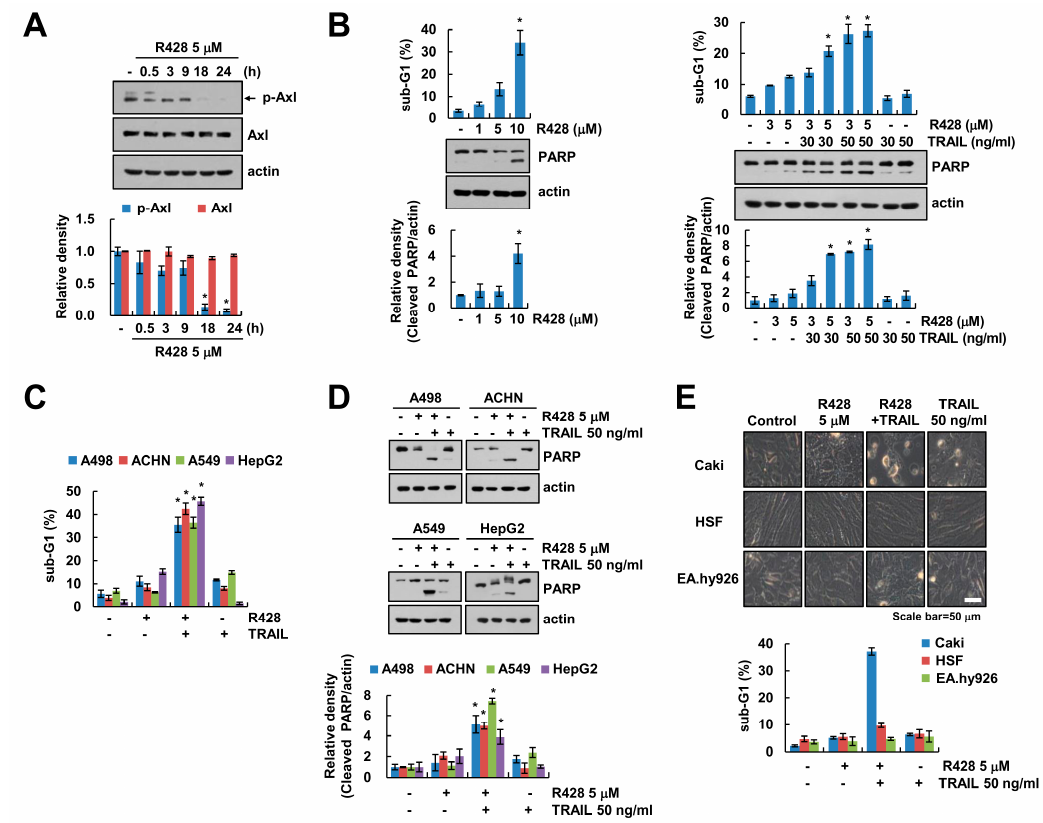
Figure 1. Inhibition of Axl increases TRAIL (tumor necrosis factor-related apoptosis-inducing ligand)-mediated apoptosis of cancer cells, but not normal cells. ( A ) Caki cells were treated with Axl inhibitor (R428) for the indicated time kinetics. ( B ) Caki cells were treated with 1–10 µM R428 for 24 h (left panel). Caki cells were treated with R428 (3, 5 µM) in the presence or absence of TRAIL (30, 50 ng/mL) for 24 h (right panel). ( C,D ) Indicated cancer cells were treated with 5 µM R428 alone, 50 ng/mL TRAIL alone or R428 plus TRAIL for 24 h. ( E ) Caki, HSF and EA.hy926 cells were treated with 5 µM R428, 50 ng/mL TRAIL or R428 plus TRAIL for 24 h. The cell morphology was examined using interference light microscopy. The sub-G1 population and protein expression were detected by flow cytometry ( B,C,E ) and Western blotting ( A,B,D ), respectively. The band intensity was quantified using Image J ( A,B,D ). The values in graph ( A – E ) represent the mean ± SEM of three independent experiments. * p < 0.05 compared to the control. Black arrow ( A ) indicated specific band of p-Axl.